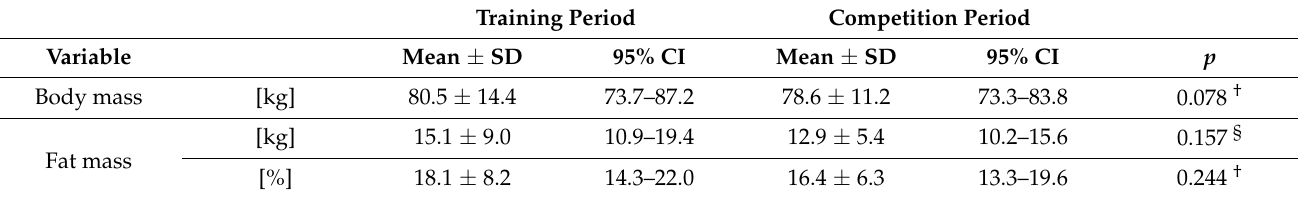
Table 2. Assessment of the anthropometric and body composition indices of athletes during the training and competition